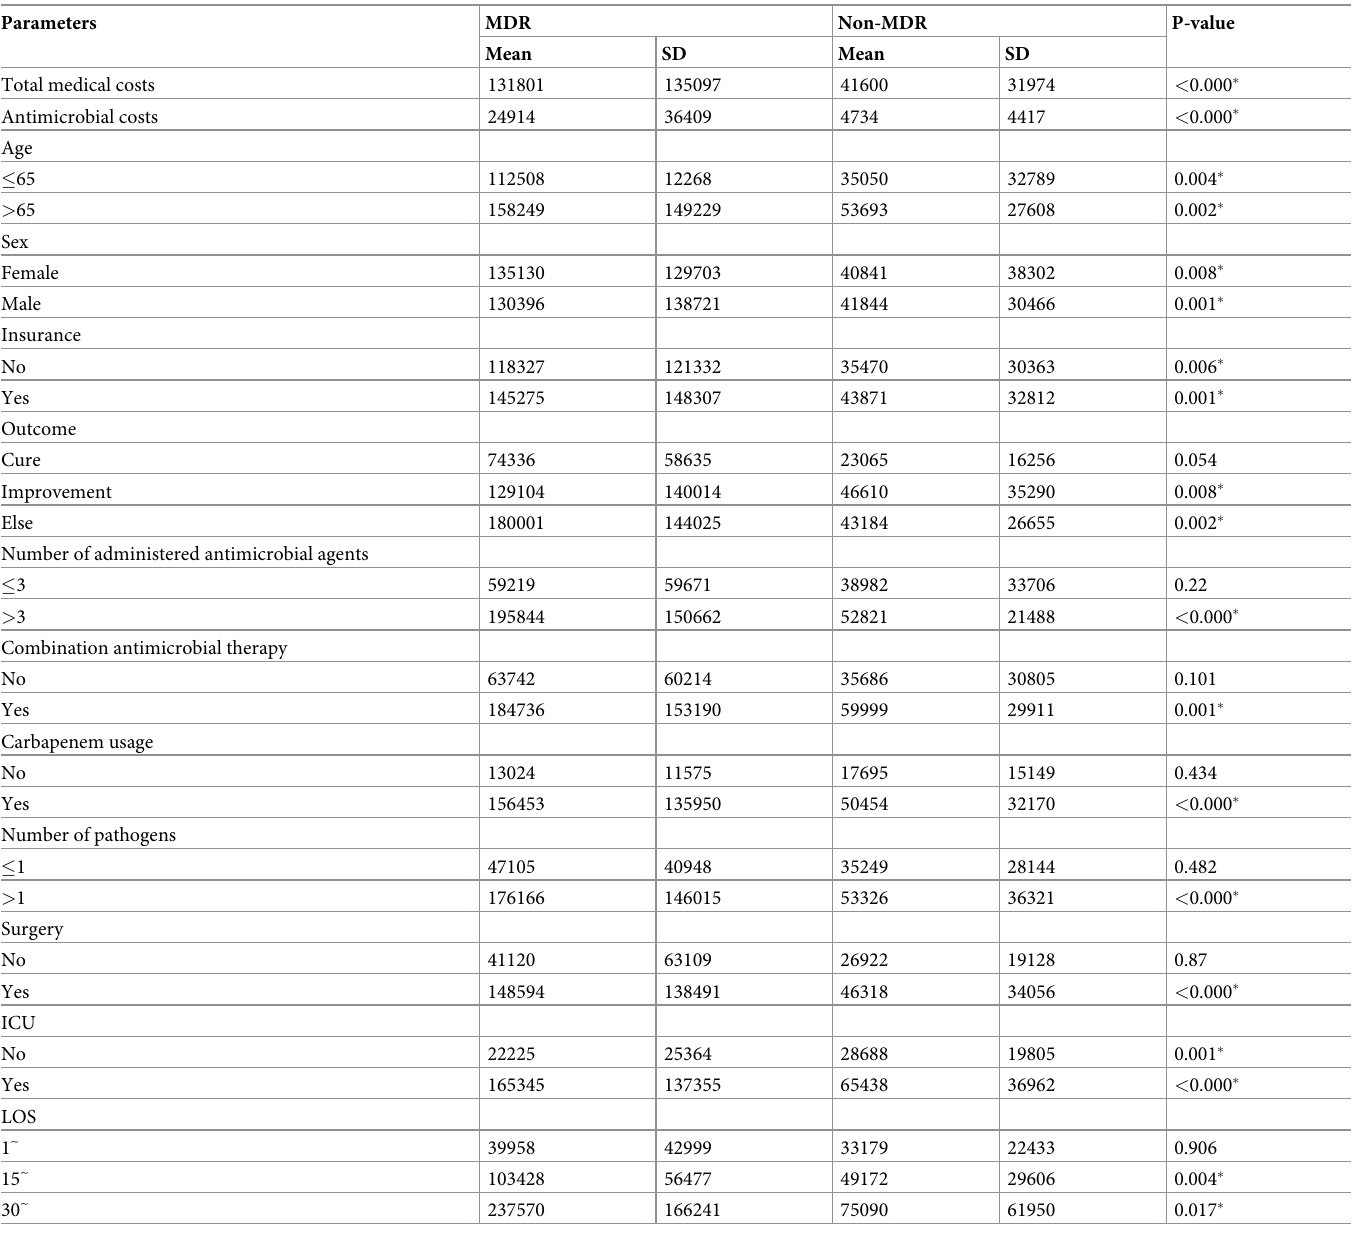
Table 2. Total medical